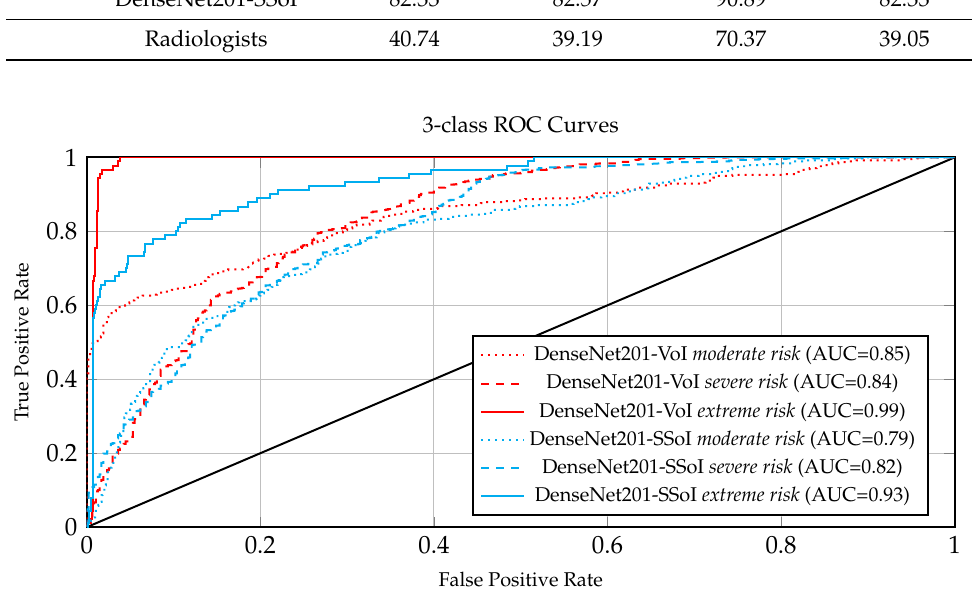
Figure 5. ROCs of DenseNet201-VoI and DenseNet201-SSoI models on COVID-19_CHDSET OS with one ROC curve plotted for each